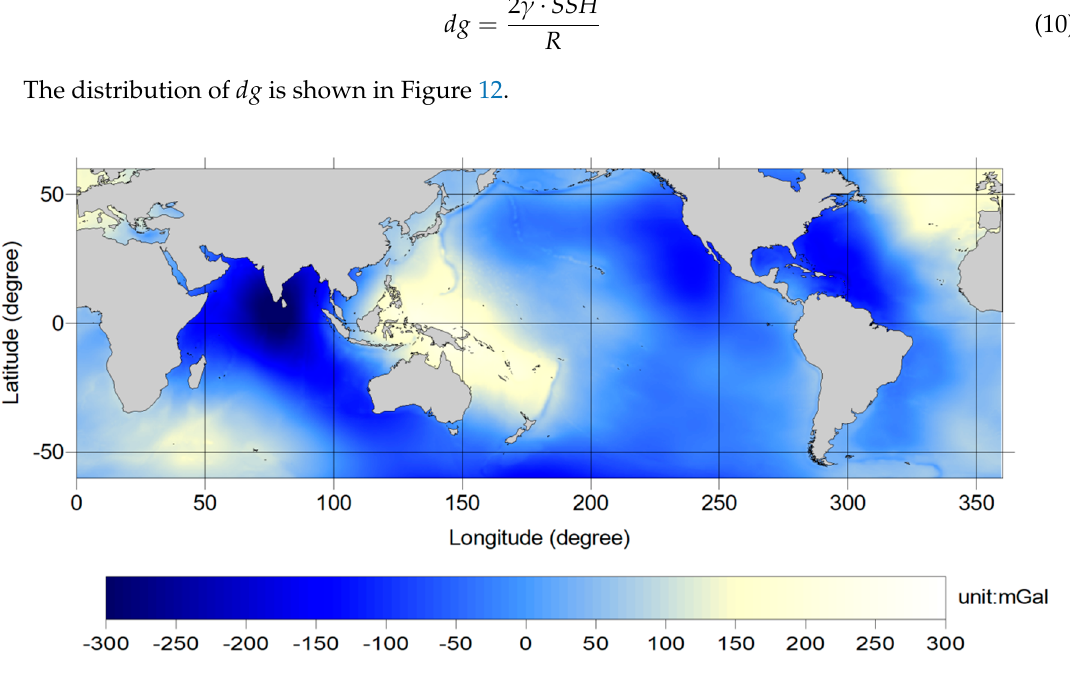
Figure 12. Distribution of dg .